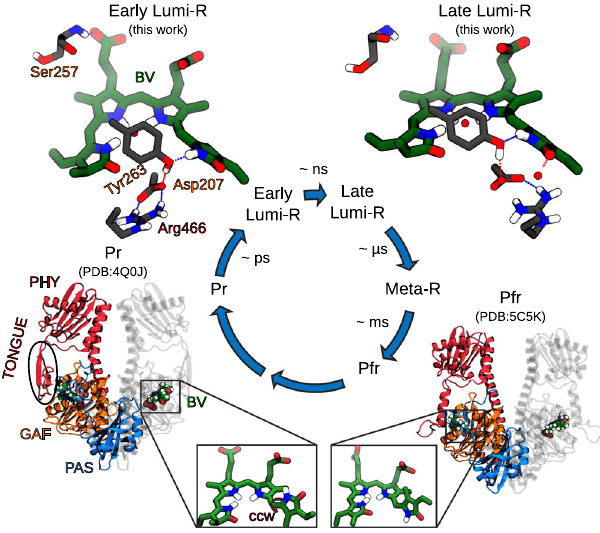
Fig. 1 | The photocycle in Deinococcus radiodurans bacteriophytochrome. RepresentationofthePSMofthetwophotoproducts:Pr(PDBID:4Q0Jhttps://www. rcsb.org/structure/4Q0J 27 ) and Pfr (PDB ID:5C5K https://www.rcsb.org/structure/ 5C5K 28 ),withazoomonthebilinchromophore(green),highlightingthePAS(blue), GAF (orange) and PHY (red) domains. The D-ring counterclockwise rotation (ccw) ofthechromophoreisrepresentedbytheredarrowintheleftinset 46 .Structuresof the chromophore and the nearby residues obtained in this work for the early and lateLumi-Rintermediatesarereportedinthetwouppercorners.Thetimescalesfor the different steps are the ones reported in the literature 36 .